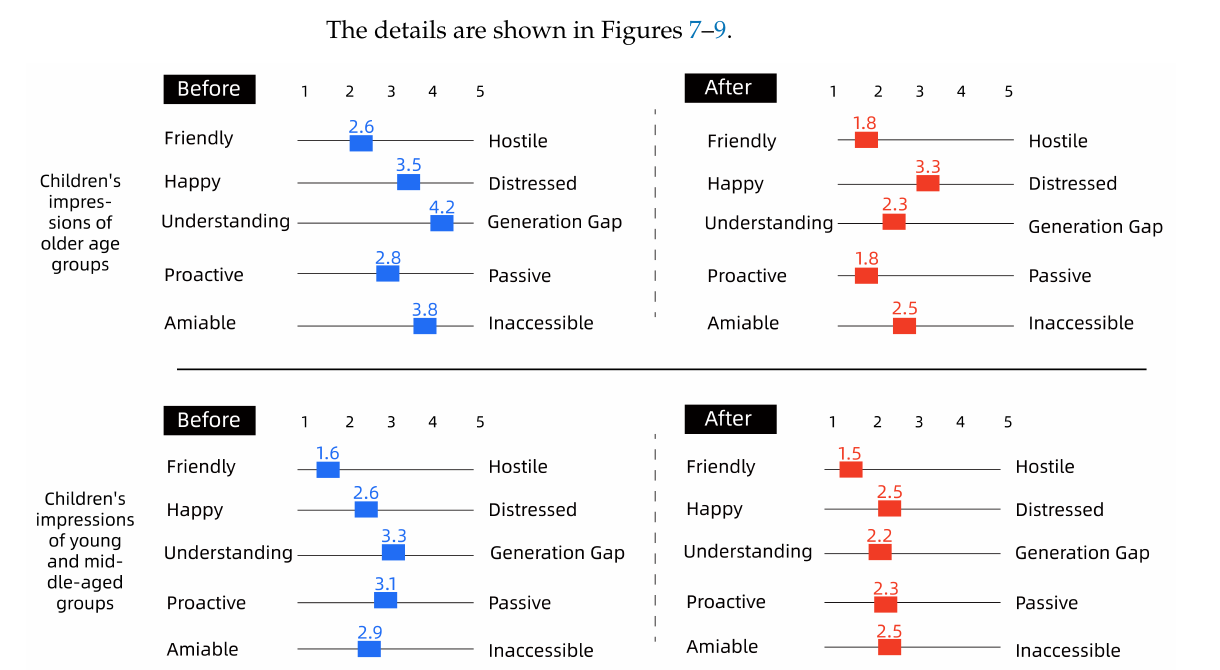
Figure 7. Children’s impressions of different ages. The children’s impressions of the different groups changed significantly and positively after the collaborative